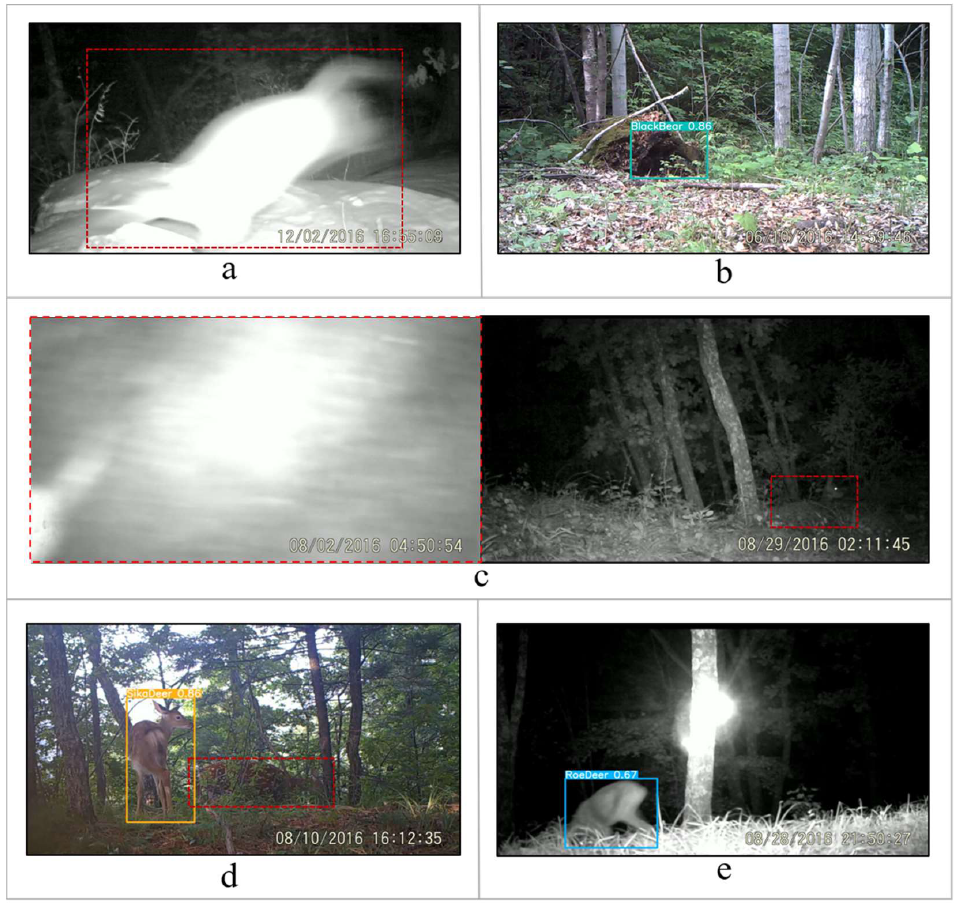
Figure 9. Examples of the typical failure cases of the models. ( a ) False negative or low recognition ratio due to poor image quality (blur, etc.); ( b ) Misrecognition of the background (stump, stone, fallen leave, etc.); ( c ) Inability to detect the target when animals are too close/far; ( d ) Inability to detect the target when animals are hidden or occluded; ( e ) Similar species are prone to misidentification. Red dotted boxes are added manually to show the missing targets.